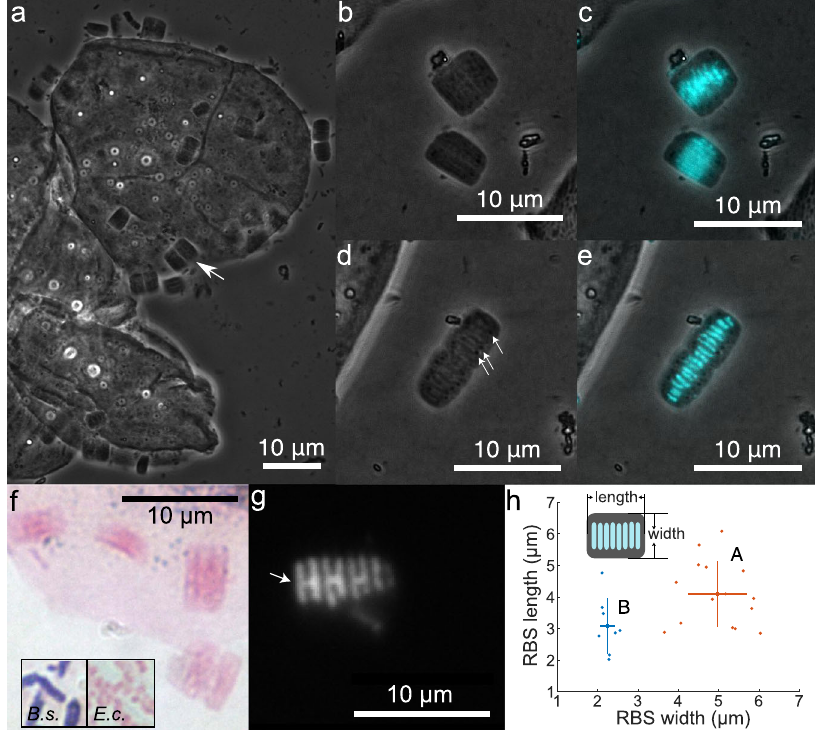
Fig. 1 | Light microscopy revealsRBSswithmultiplemorphotypes and distinct DNA banding patterns. a Phase-contrast images of RBSs (arrow indicates one example) on the surface of dolphin oral epithelial cells. Also see Supplementary Movie1. b , c SomeRBSsexhibitedlongbandsofDAPI fl uorescence.Phase-contrast image is shown in ( b ), with fl uorescence overlay in cyan in ( c ). d , e Other RBSs exhibited shorter DAPI bands. Phase-contrast image is shown in ( d ), with fl uores- cence overlay in cyan in ( e ). Dark spots (arrows) were organized in lines perpen- dicular to DAPI-stained bands. DAPI-stained bands appeared to be organized in pairs. f Gram-stained RBSs display Gram-negative characteristics. Inset: Gram-